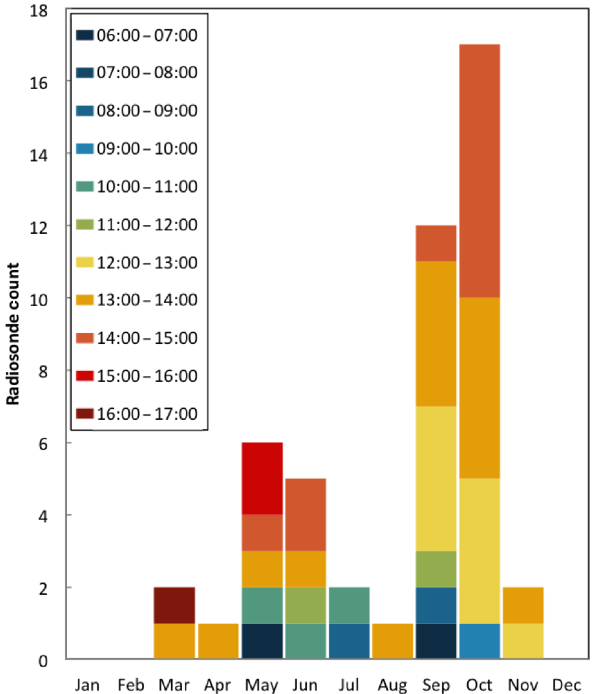
Figure 1. Cloud-free radiosonde launches used for the method com- parison specified by the time of launch in